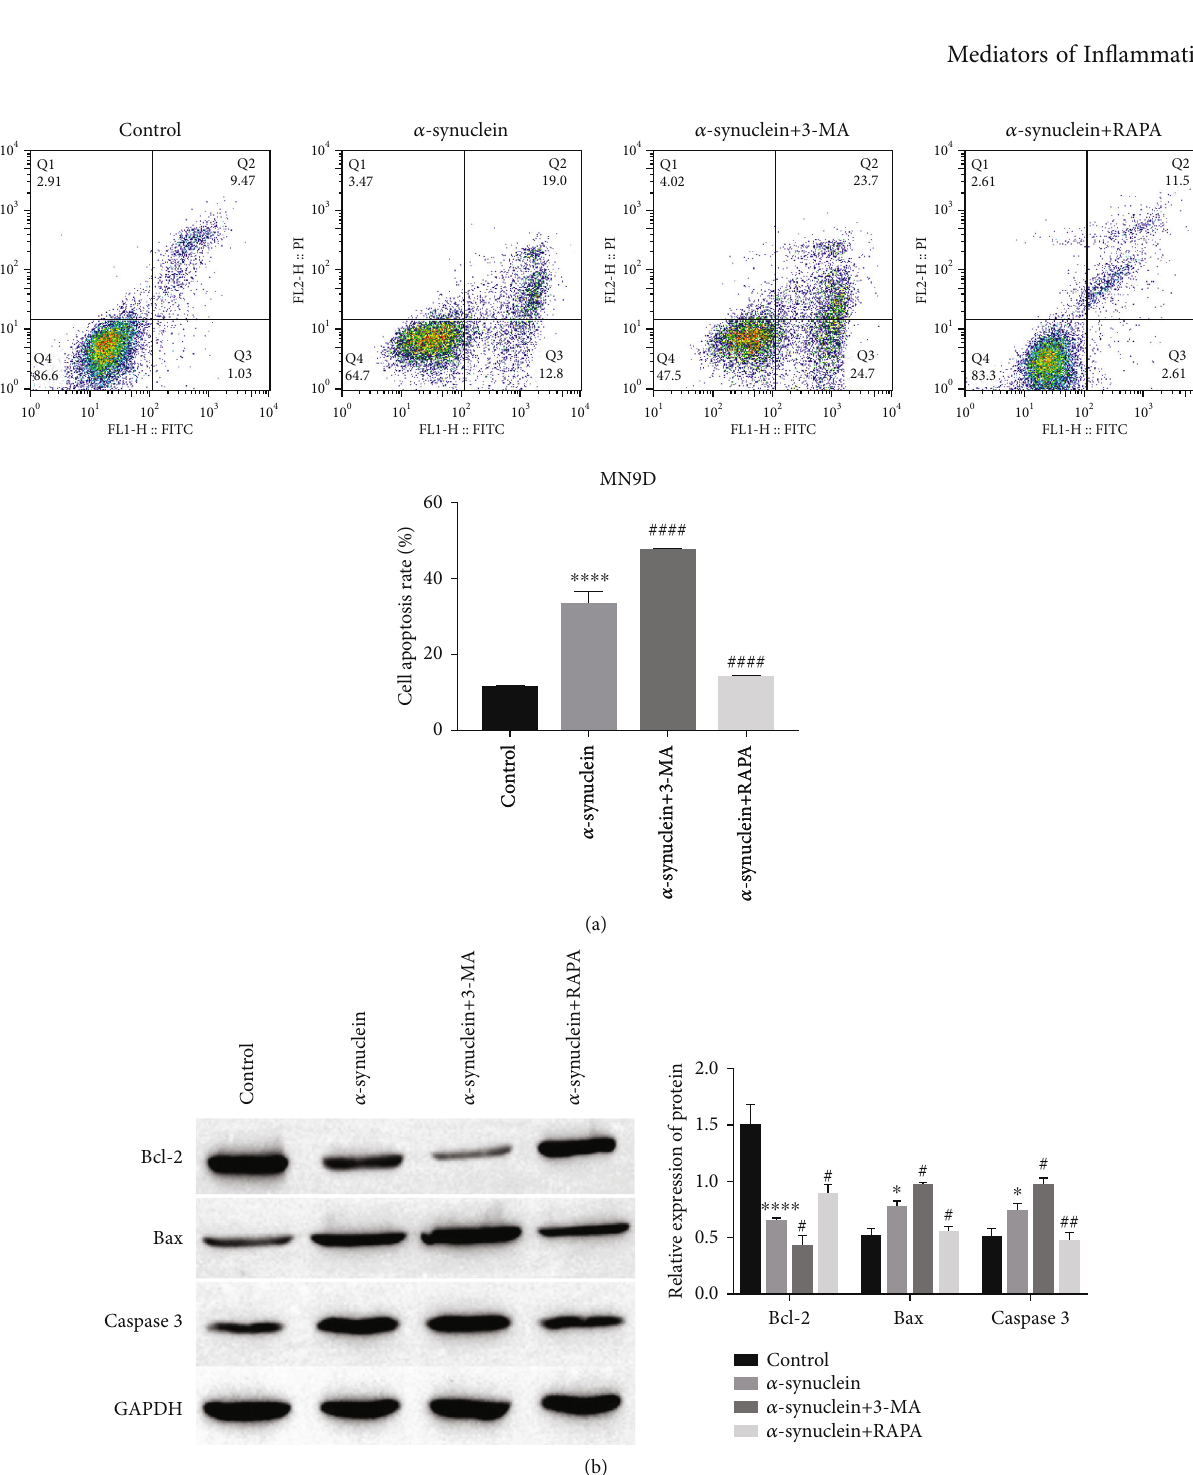
Figure 6: E ff ect of activation and autophagy-impaired microglia on apoptosis of dopaminergic neuronal cells. (a) Apoptosis of dopaminergic neurons in MN9D cells was detected by fl ow cytometry, ∗∗∗∗ P < 0 : 0001 vs. control and #### P < 0 : 0001 vs. α -synuclein. (b) The expressions of Bcl-2, Bax, and Caspase 3 were detected by western blot, ∗ P < 0 : 05 and ∗∗∗∗ P < 0 : 0001 vs. control and # P < 0 : 05 and ## P < 0 : 01 vs. α